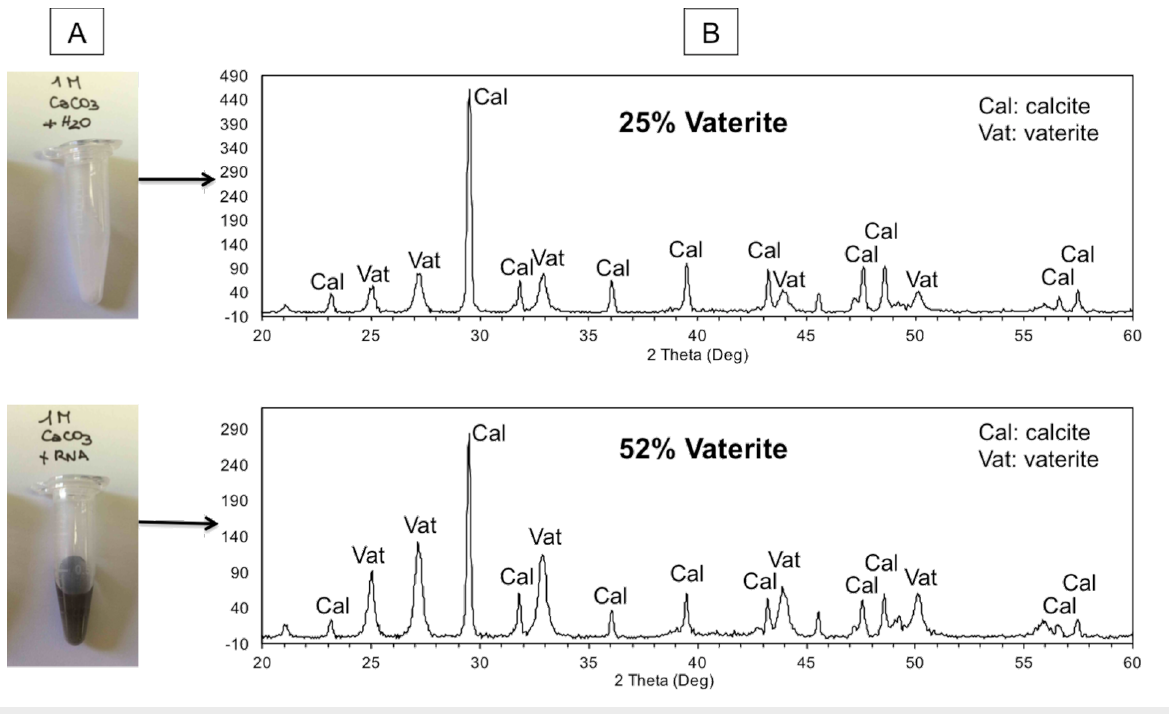
Figure 3: RNA-induced calcium carbonate polymorphism. A: Feigl’s stain of CaCO 3 precipitate formed by double decomposition of 1 M CaCl 2 + 1 M Na 2 CO 3 in the absence (upper tube) or presence (lower tube) of RNA. B: X-ray powder diffraction of samples prepared the same way showing a net increase in vaterite versus